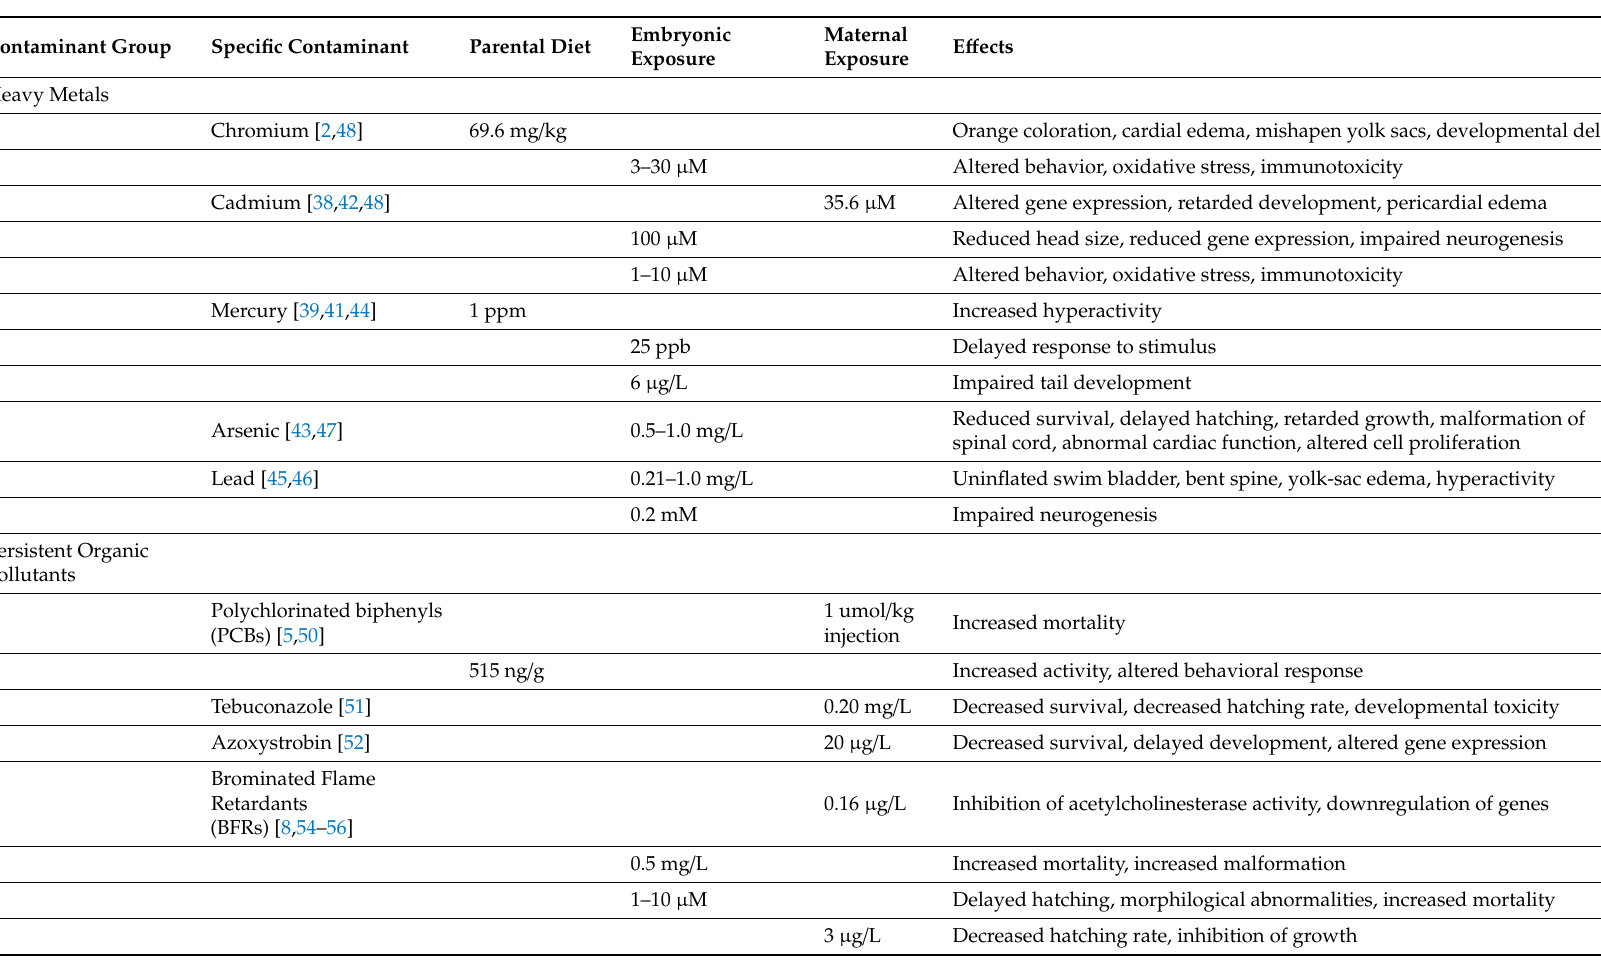
Table 2. Summary of contaminants and their e ff ects on zebrafish embryos and larvae due to exposure via parental diet, embryo exposure, or maternal